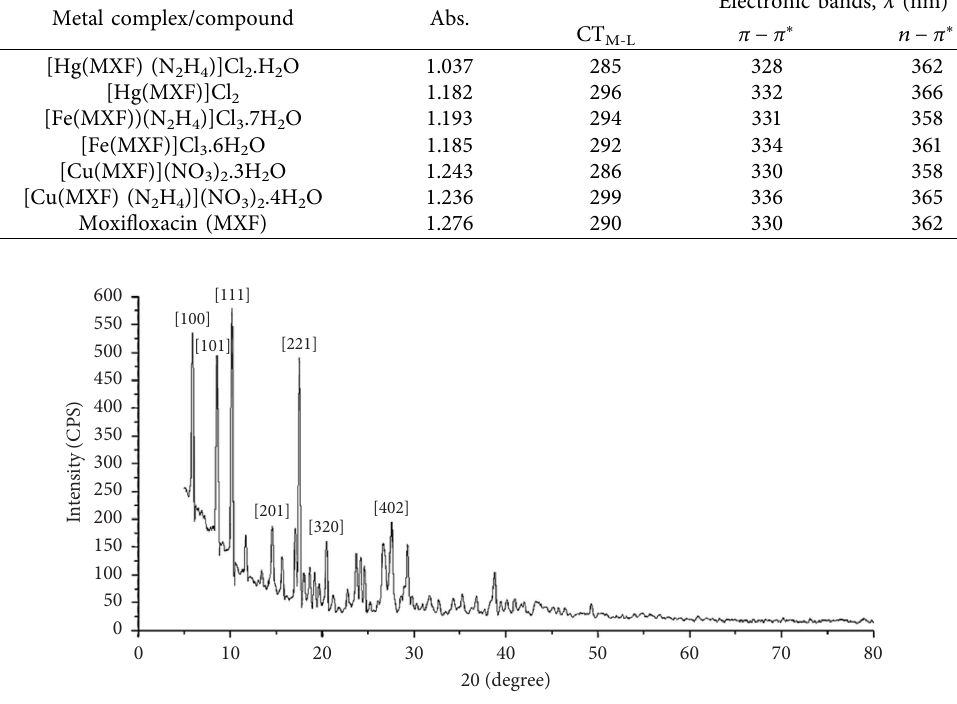
Figure 2: Powder X-ray difractograms of moxifoxacin.